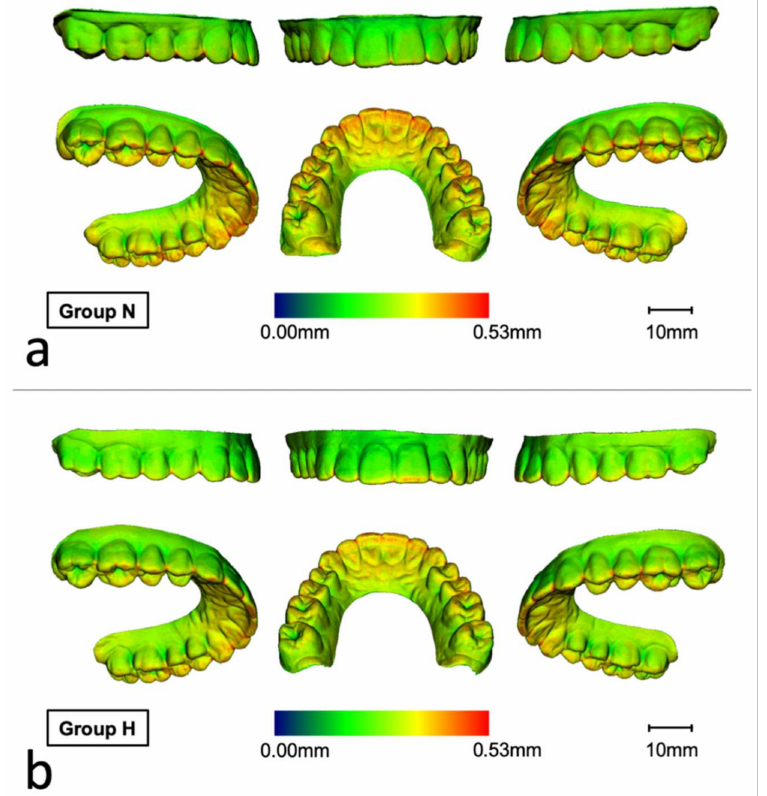
Figure 2. Representative renderings visualizing the local material thickness of micro-CT scanned aligners thermoformed at ( a ) narrow (N) or ( b ) heigh (H) dental models (blue: 0.00 mm, red: 0.53 mm). Thickness values were higher in the N group compared to the H group, especially in the anterior palatal area, occlusally and on incisal